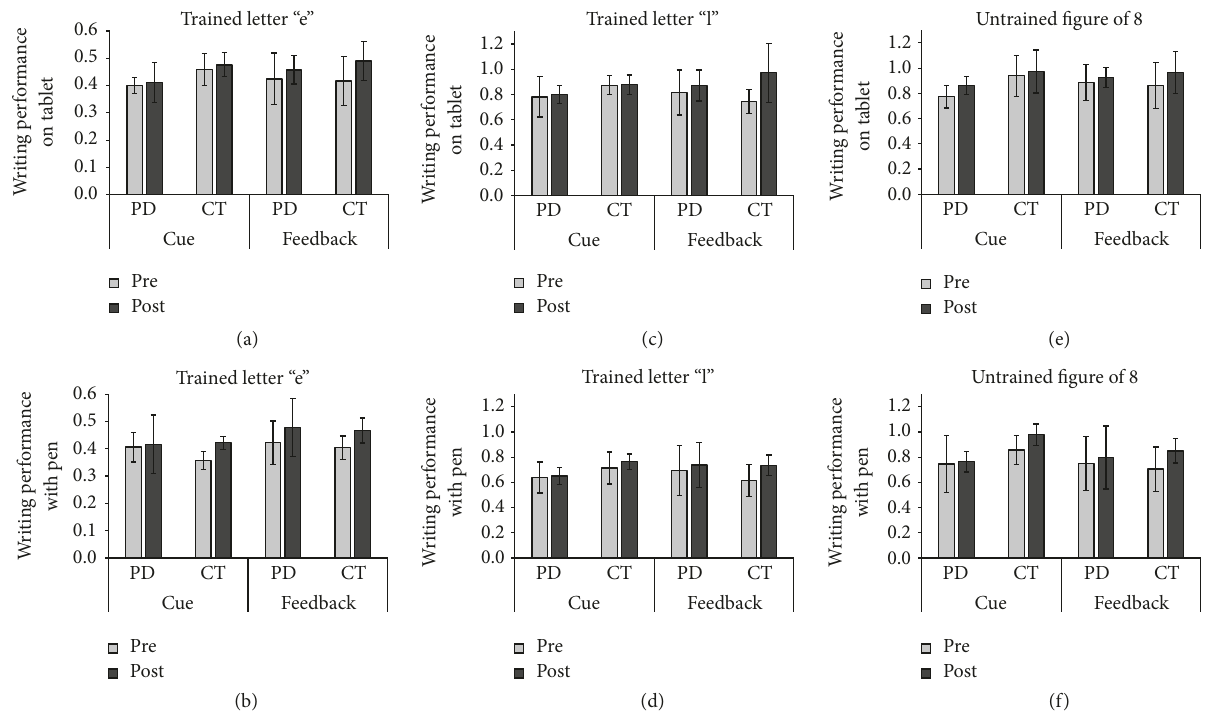
Figure 2: The effects of short-term training with visual cues or intelligent feedback . Results are displayed for the different tasks and groups, performed both on the touch-sensitive writing tablet and with the feedback pen.